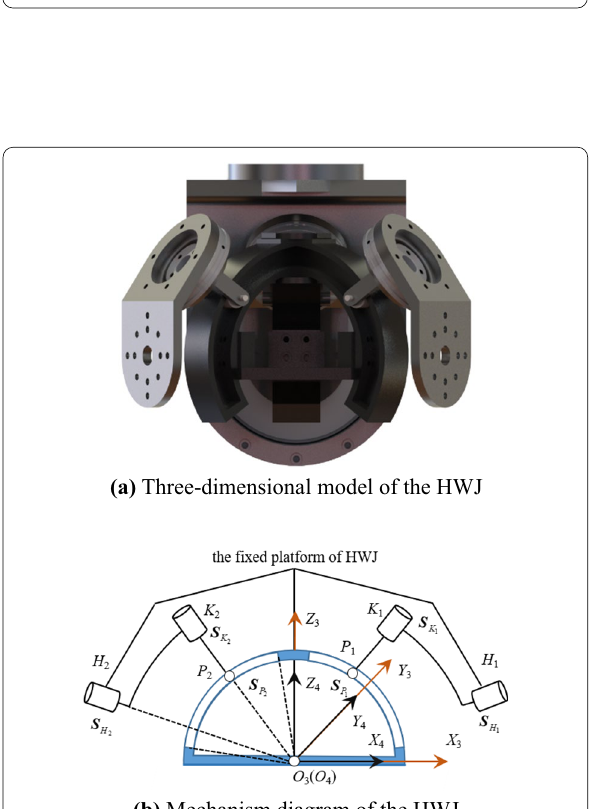
(b) Mechanism diagram of the HEJ Figure 7 Structural configuration of the HEJ